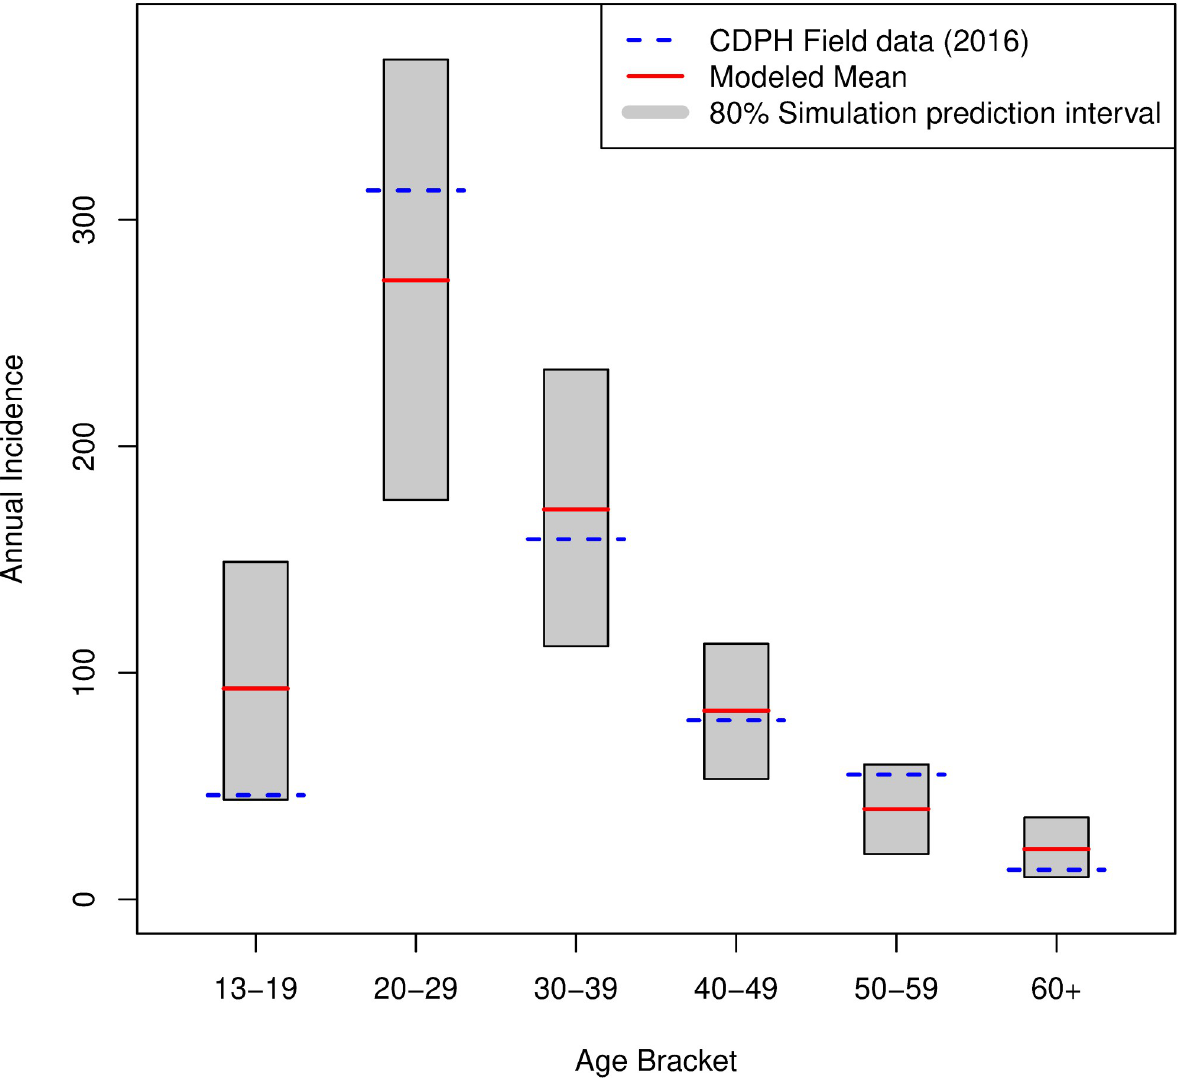
Fig 2. Incidence by age: Observed and predicted annual incidence cases by age, the modeled 80% prediction range (grey), the modeled mean value (red), and the count observed in 2016 field data from the Chicago Department of Public Health. https://doi.org/10.1371/journal.pone.0274288.g002 (Path 1, bold black line) entails increases in PrEP linkage (level � 3), PrEP retention (level � 2), and PrEP adherence (level 2). The second most efficient path (68%)(Path 2, dotted line) entails increases in PrEP linkage (level � 3) and PrEP retention (level � 2), and allows PrEP adherence levels of < 2. Path 2 includes the baseline unperturbed level and it does not require a specific level of PrEP adherence. Instead, it requires the highest level of ART retention, and reaches its goal only by combining treatment and prevention levers. The third most efficient path (63%) (Path 3, dashed line) entails increases in PrEP linkage (level � 3), PrEP adherence (level 2) and ART retention (level 3). Unlike Path 1 and 2, Path 3 does not require any specific levels of PrEP retention. Compared to the best path, Path 1, Path 3 permits lower levels of PrEP reten- tion but requires maximum ART retention, yielding a 14% reduction (63% vs. 77%) in the pro- portion of runs attaining the 2025 goal.